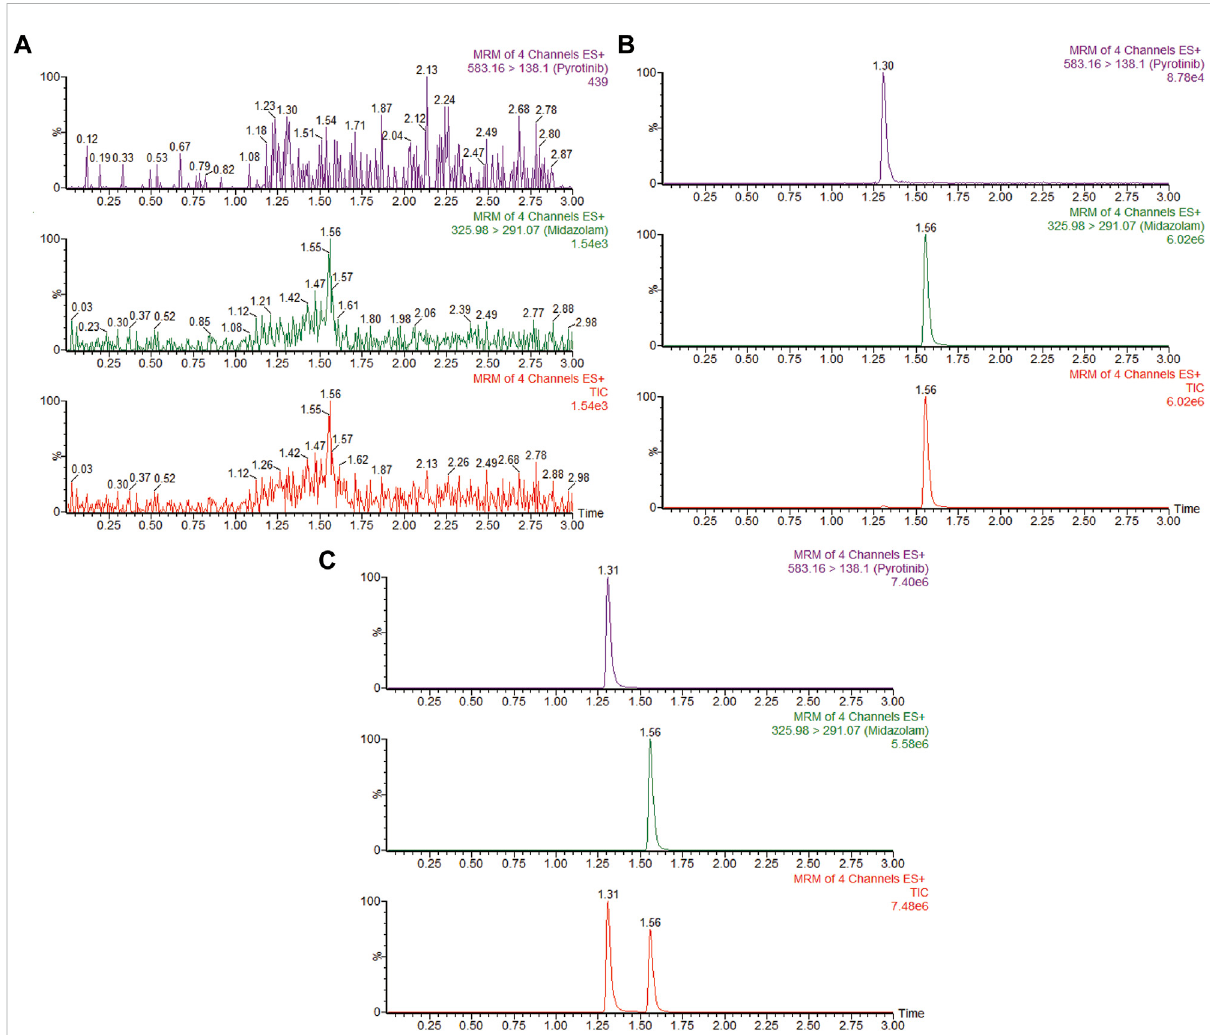
FIGURE 7 MRMchromatogramsofpyrotinibandIS invivo . (A) Blankratplasmasample. (B) DenaturedblankratplasmasamplewithpyrotinibandIS. (C) Rat plasma sample after dosing pyrotinib with oral